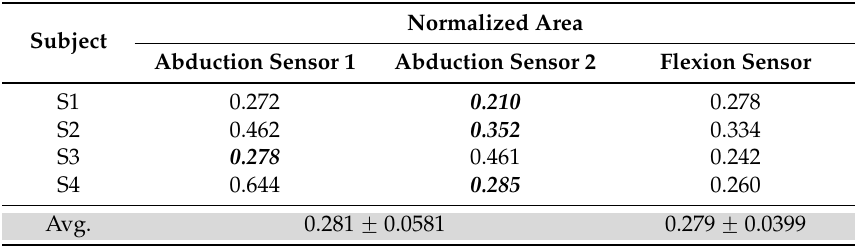
Table 2. Normalized area at the optimal sensor